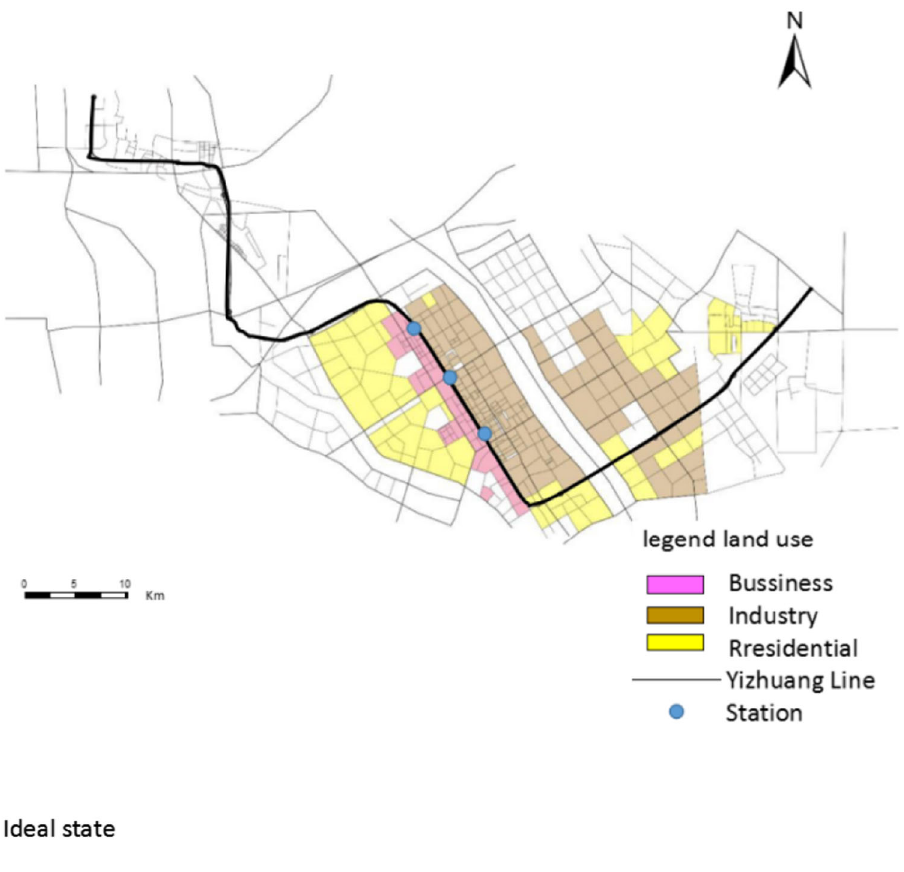
Fig. 7 Planned ( above ) and actual ( below ) commuting